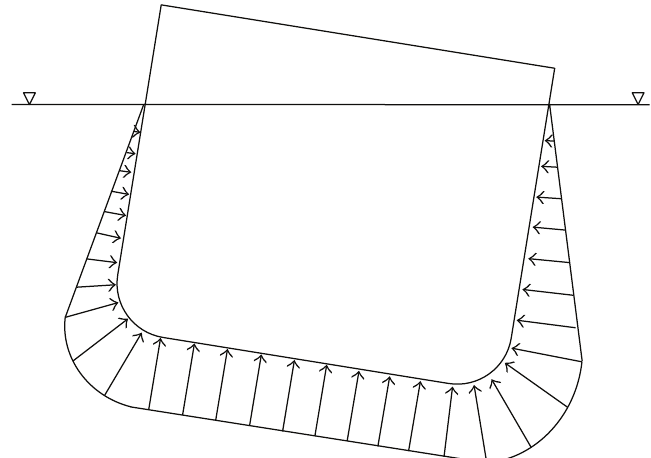
Figure 2: Roll motion of a vessel causing nonuniformity of lateral pressure load distribution in the hull